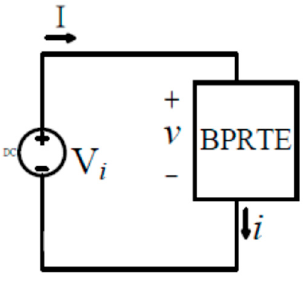
Figure 2. Single PVCDR RTEC unit without C p , R S , and L S [1].